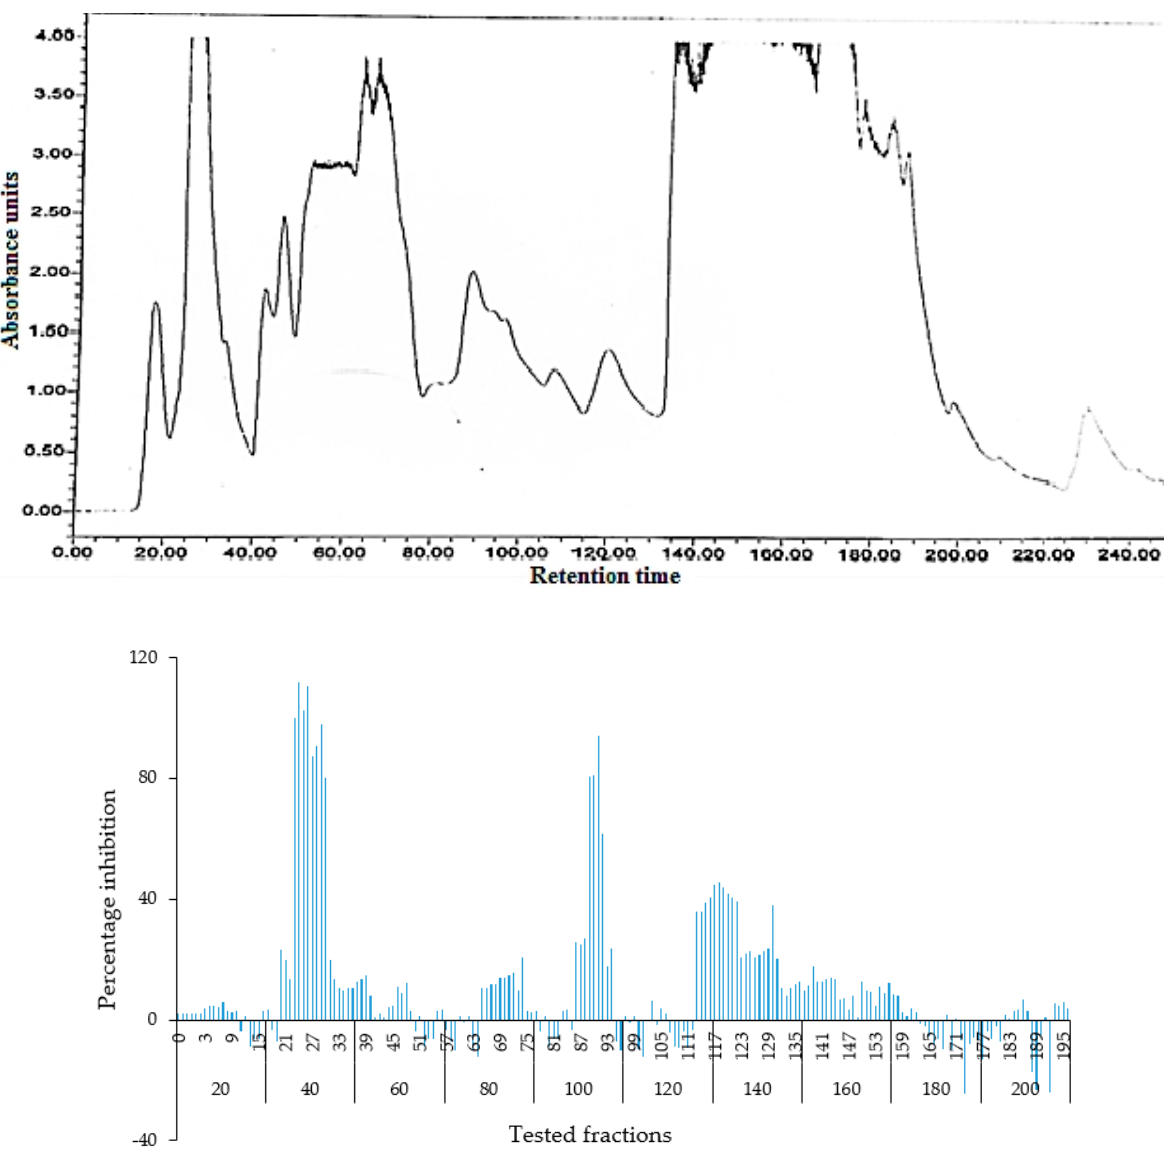
Figure 4. Top panel : Overlaid chromatogram of from a silica gel column of the hexane extract of Bidens bipinnata leaves; fractions were collected per minute and tested for activity (percentage inhibition of C. albicans ) ( bottom panel ).